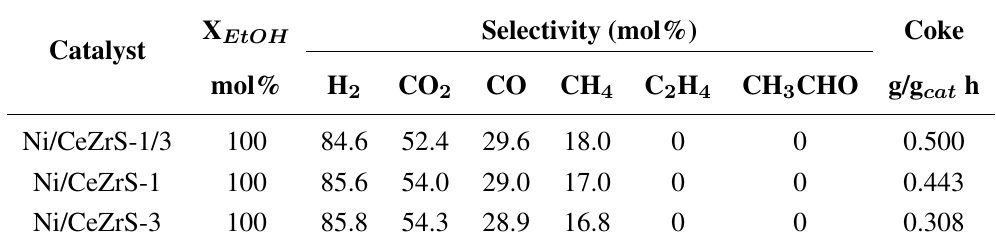
Results on ethanol steam reforming obtained with the Ni/Ce catalysts (atmospheric pressure; T: 600 ◦ C ; weight hourly space velocity